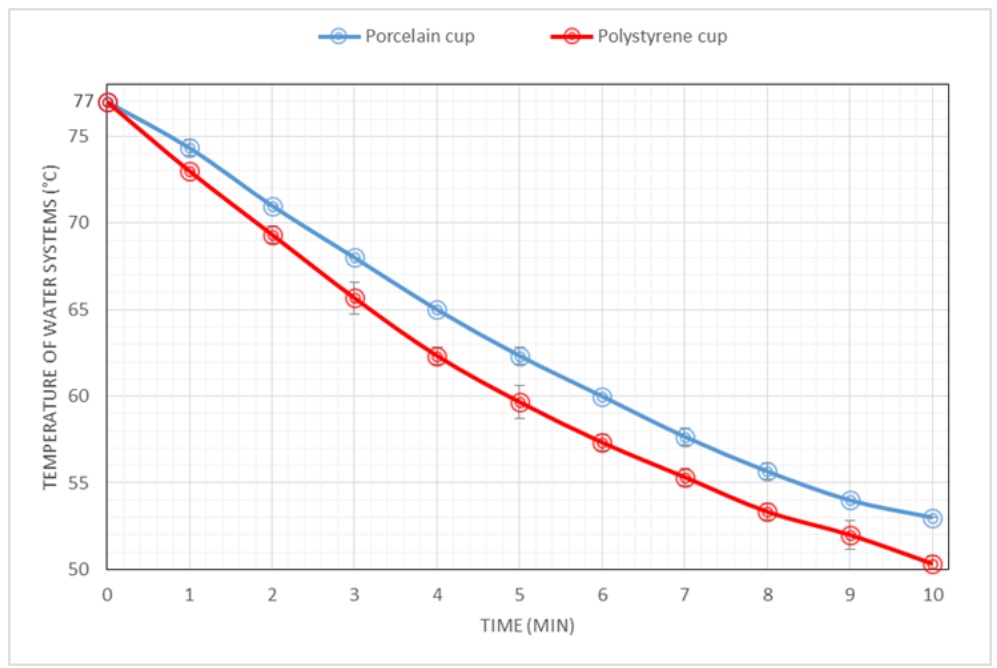
Figure 3. Cooling behavior (temperature as a function of time) of hot water systems from 77 °C in 50 mL porcelain and polystyrene (disposable) cups, both at ambient temperature of 25 °C. Temperatures of the water systems were collected in one minute intervals up to 10 min. Point values are shown as mean of 3 repetitions ± standard deviations of each experiment and the coefficient of variation never exceeded 1.6%.